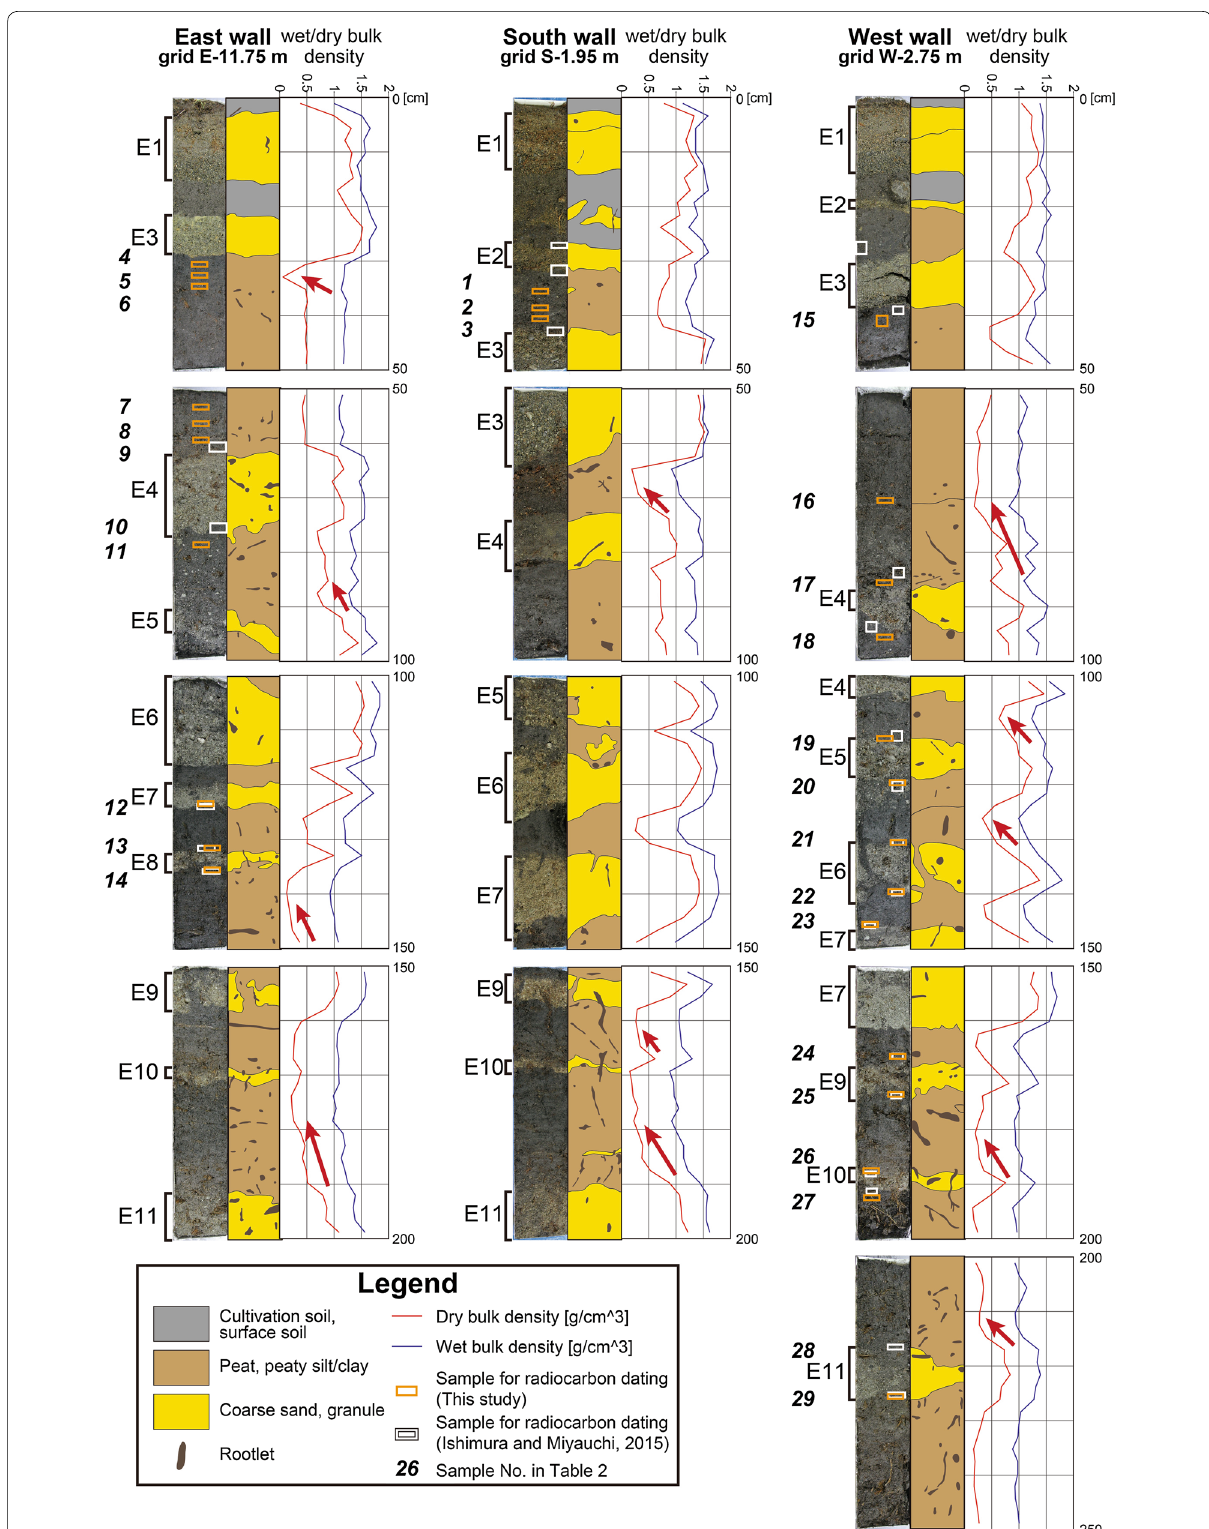
Fig. 2 Block samples from the KYD trench and sample positions of the radiocarbon dating. The photographs, sketches, and density results were modified after Ishimura and Miyauchi (2015). Detailed locations of block samples are shown in Additional file 1: Figure S1. Red arrows indicate gradual density decrease above tsunami